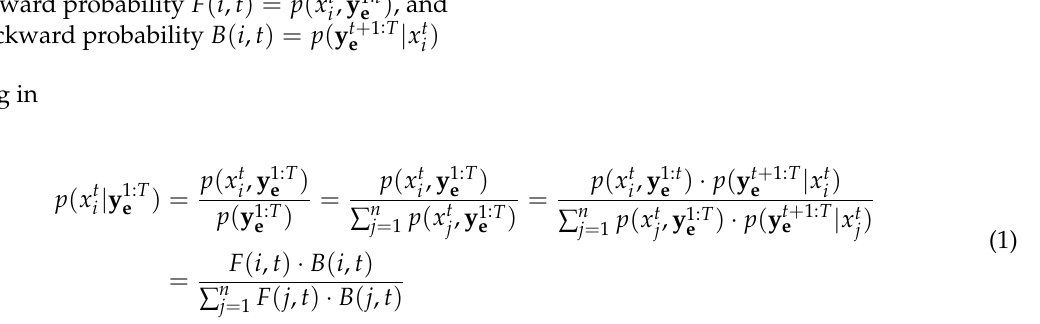
Figure 1. ( a ) An example of an HMM representation. ( b ) Its dynamic Bayesian network representation, unrolled for T time